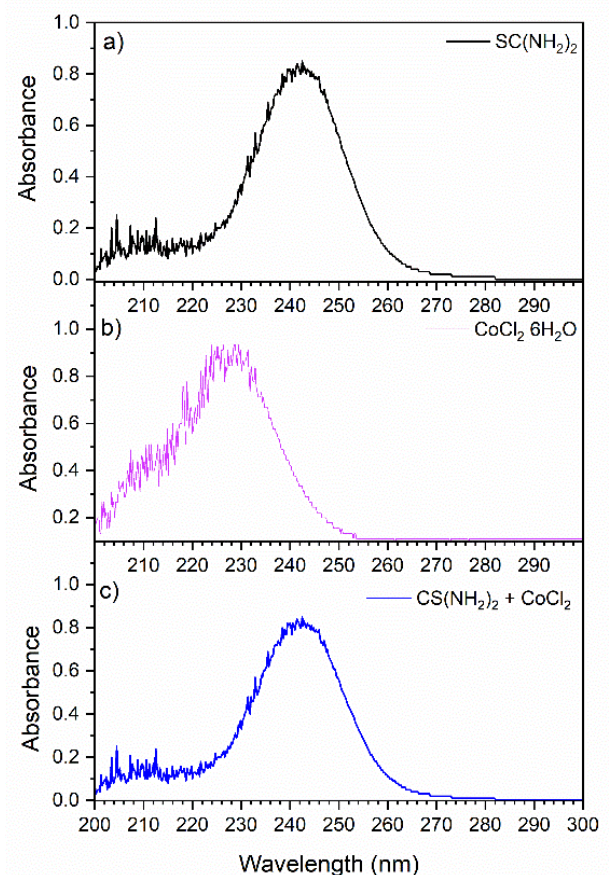
Figure 3. Absorption ranges of solutions: ( a ) SC(NH 2 ) 2 ; ( b ) CoCl2 · 6H2O; ( c ) [SC(NH 2 ) 2 ] 2 · CoCl 2 .